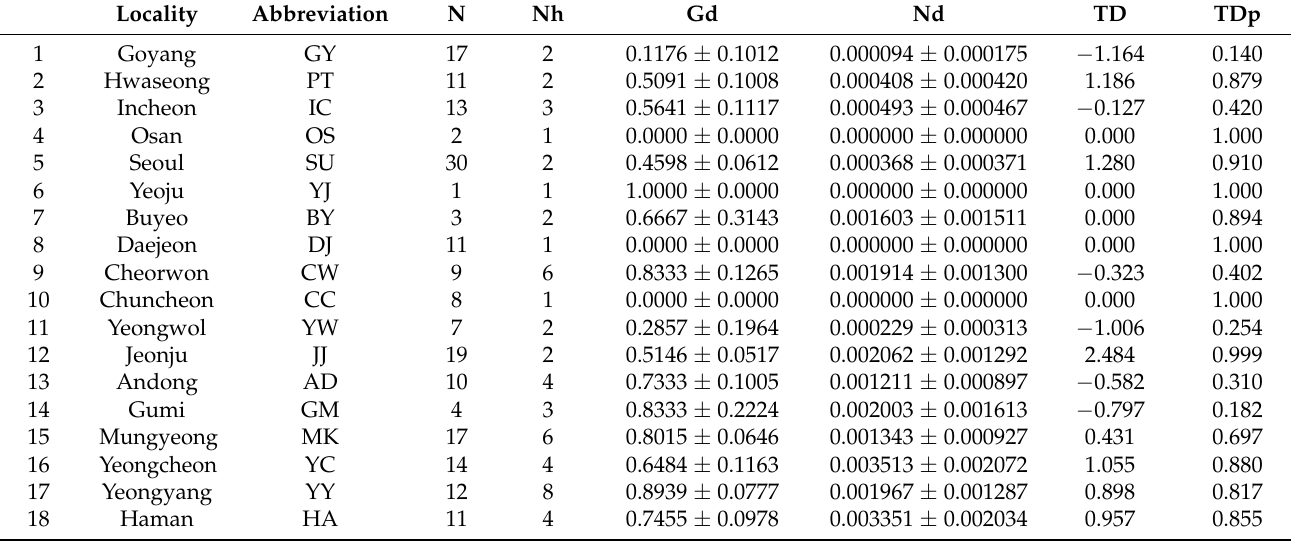
Table 2. Collected locality, abbreviation, number of samples (N), number of haplotypes (Nh), genetic diversity (Gd), nucleotide diversity (Nd), Tajima’s D (TD), and p -value of TD (TDp) based on 1248 bp